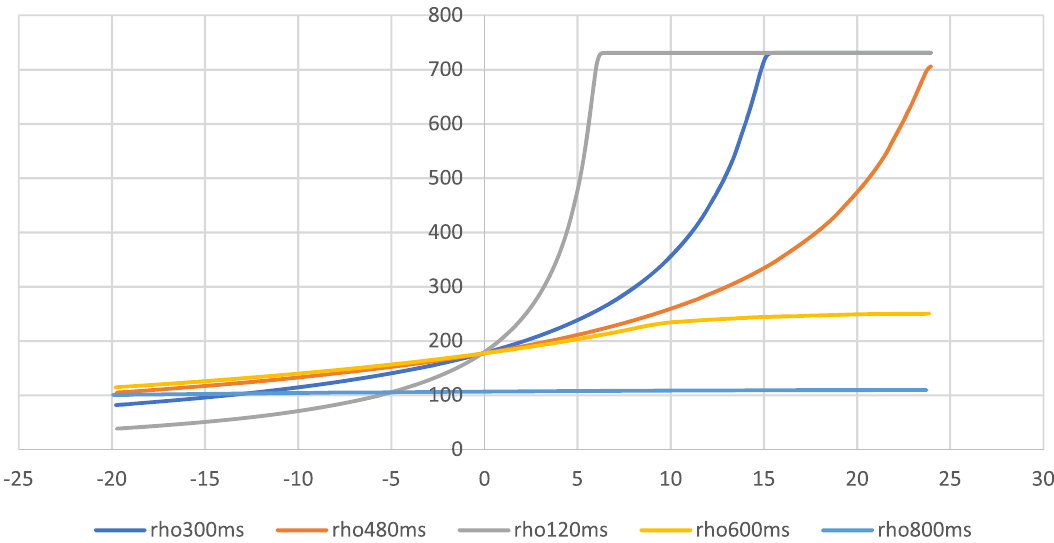
Fig. 17. Evolution of volumic mass along the 24m pressure